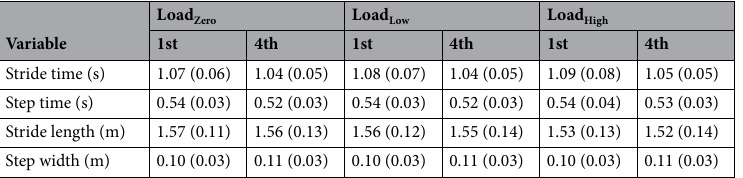
Table 2. Gait measures for each load condition and experience group. All values reported as means (SDs).